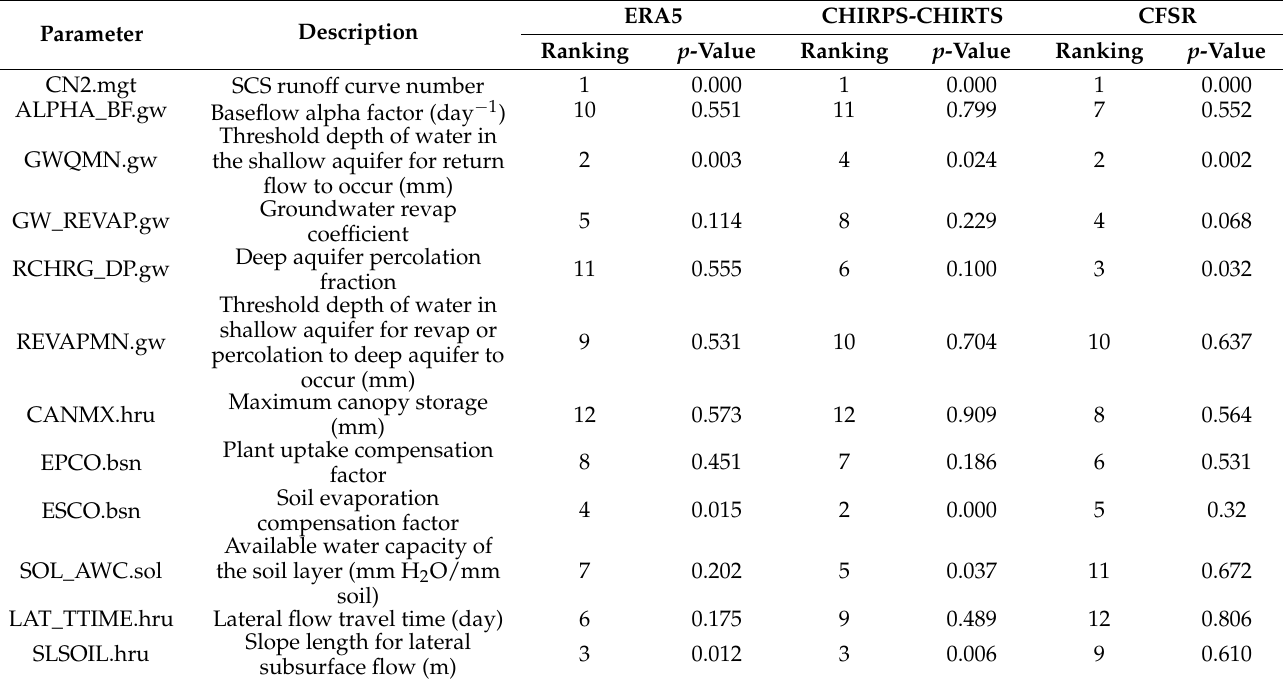
Table 2. Sensitivity analysis of SWAT model parameters for the GSM River